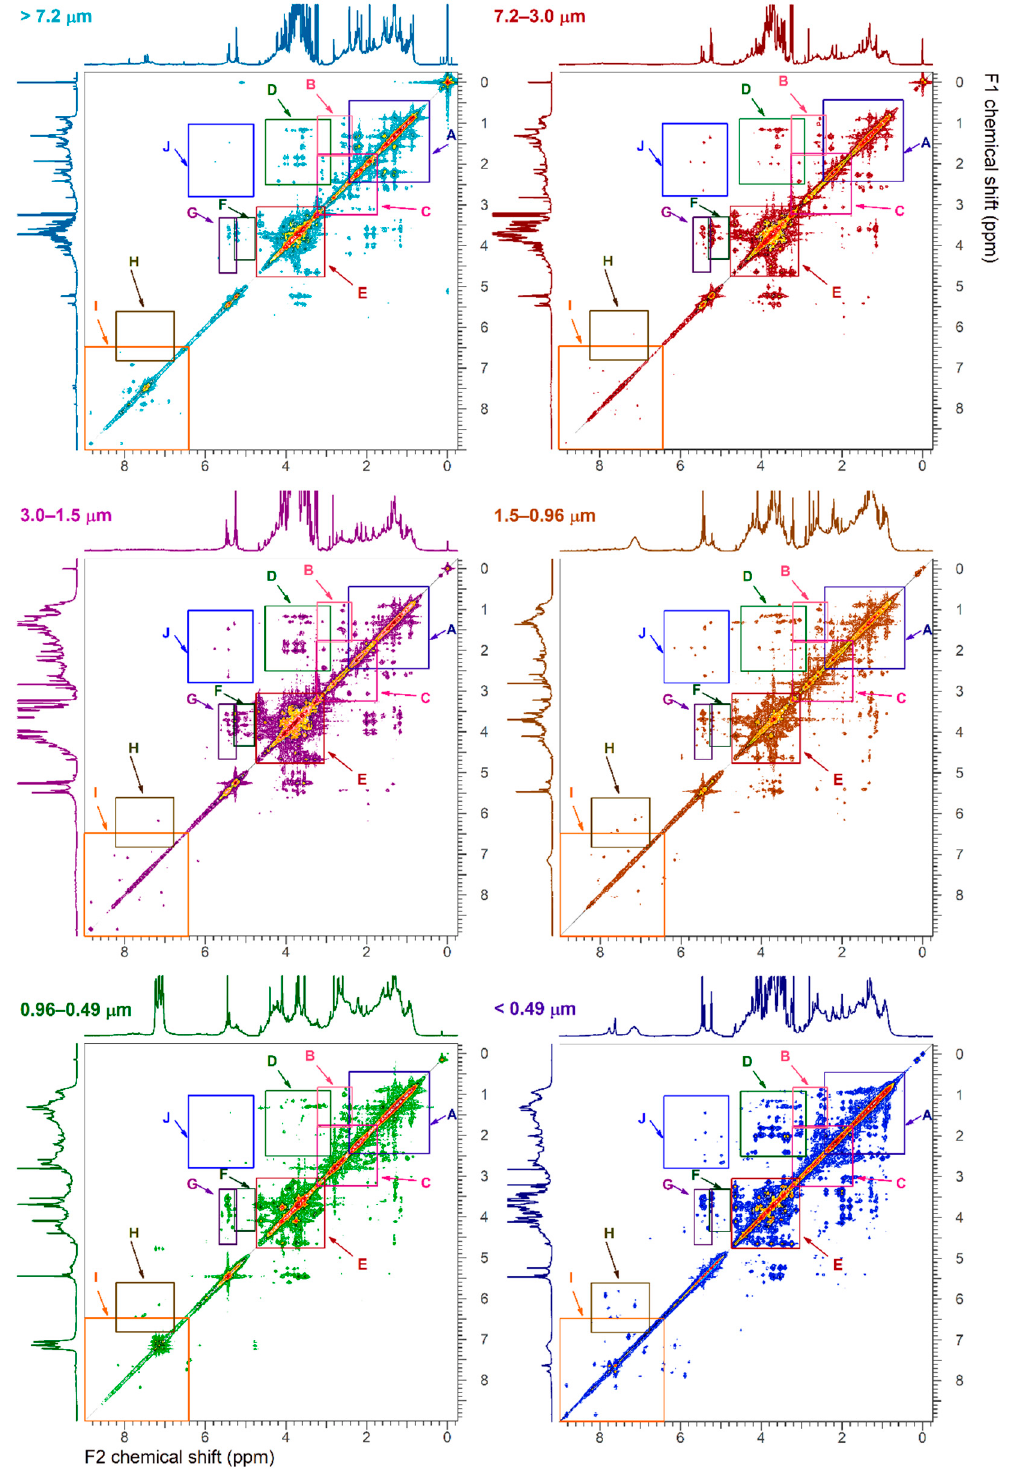
Figure 5. 1 H- 1 H TOCSY NMR spectra of size fractionated water-soluble organic carbon. The regions A through G and J are detailed in Figure S2, the regions H and I in Figure S10. The x-axis F2 represents the proton frequencies obtained in the direct dimension and the y-axis F1 represents the proton frequencies obtained in the indirect dimension.